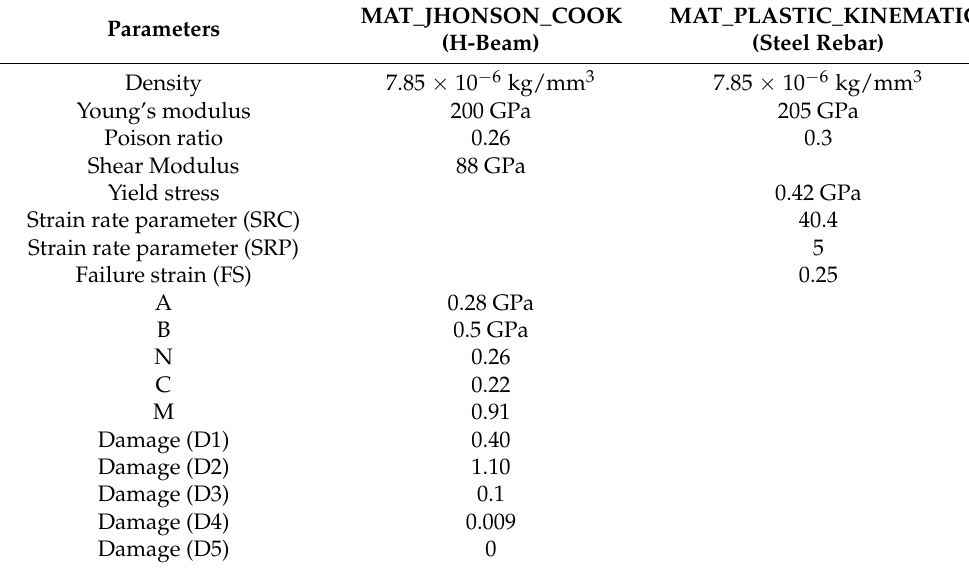
Table 4. Properties of rebar and